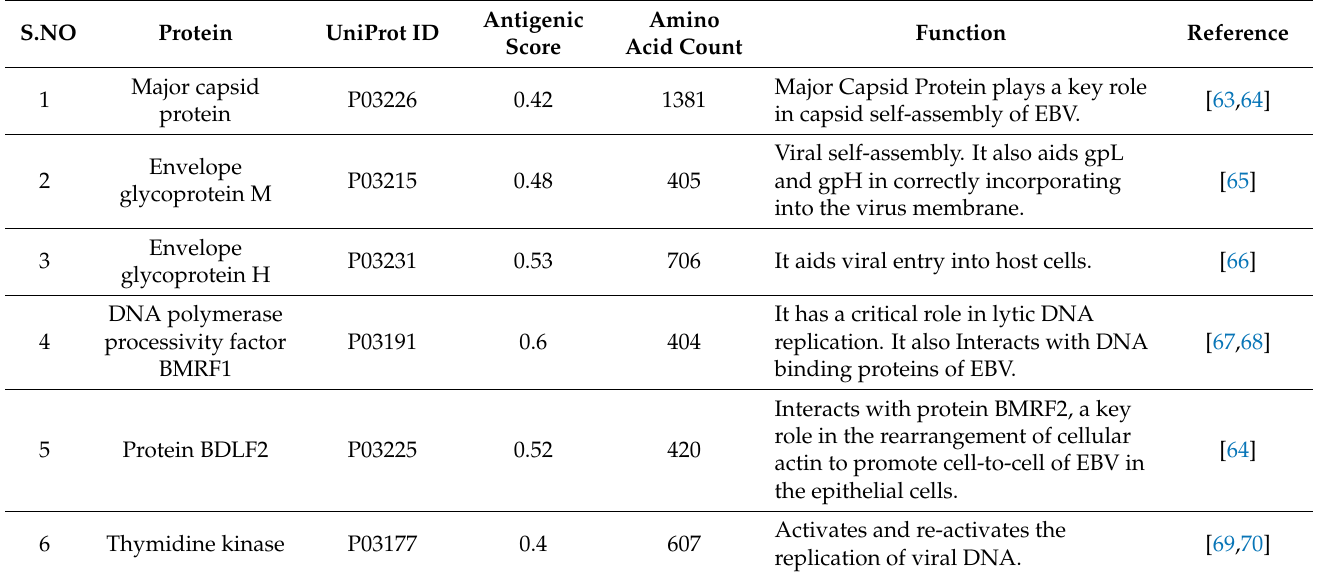
Table 1. Selected proteins with respective antigenic scores predicted by the Vaxijen